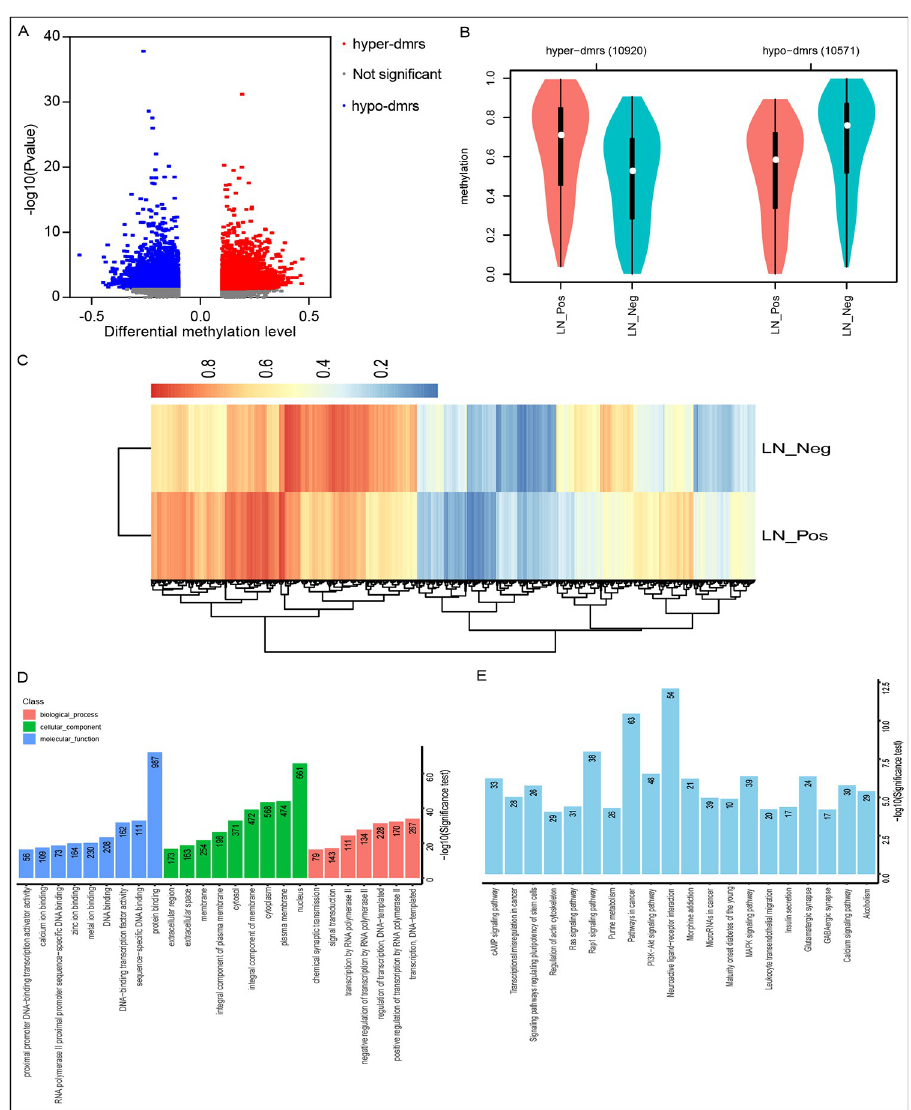
Fig 1. Differentially methylated regions (DMRs) analysis. A. Volcano plot showing mean methylation differences between LN positive and LN negative breast cancer (x axis) versus log transformed p-values (y axis). B. Violin boxplot showing the average methylation level distribution of DMRs. C. Cluster according to the average methylation level of the DMRs. D. The GO analysis of DMRs between LN positive and LN negative breast cancer. E. The KEGG analysis of DMRs between LN positive and LN negative breast cancer. LN, Lymph node; hyper-dmrs, hypermethylated DMRs; hypo-dmrs, hypomethylated DMRs.